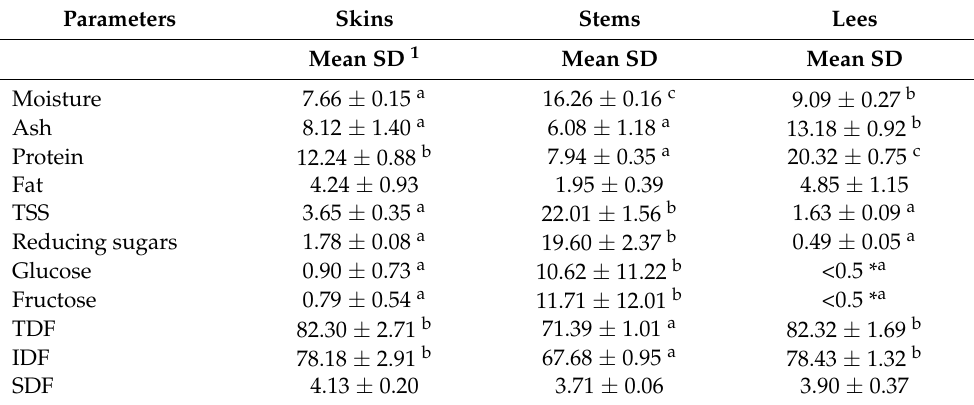
Table 1. Chemical composition of skins, stems, and lees (g/100 g dry weight). Parameters Skins